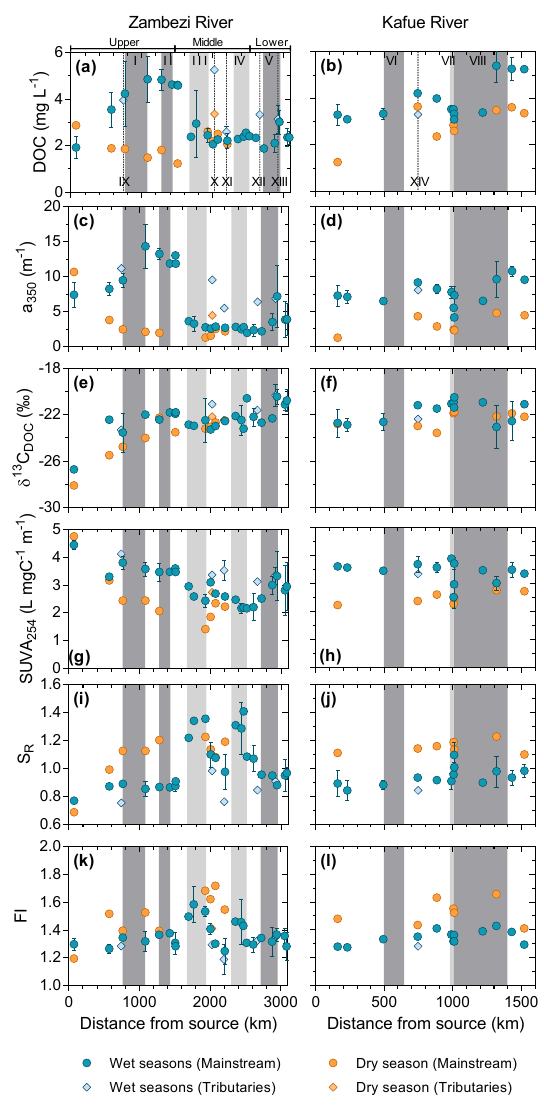
Figure 3. Longitudinal variations in DOM properties along the Zambezi River (left panels) and the Kafue River (right panels) dur- ing the wet and the dry seasons. From top to bottom, the panels represent DOC, a 350 , δ 13 C DOC , SUVA 254 , S R and FI. Dark-gray and light-gray rectangles in the background represent the approx- imate position along the mainstream of wetlands/floodplains areas and reservoirs, respectively. Roman numerals refer to (I) Barotse Floodplain, (II) Chobe Swamps, (III) Kariba Reservoir, (IV) Ca- hora Bassa Reservoir, (V) lower Zambezi wetlands for the Zam- bezi River and (VI) Lukanga Swamps, (VII) Itezhi Tezhi Reservoir, and (VIII) Kafue Flats for the Kafue River. The diamonds represent samples collected from main tributaries upstream of their conflu- ence with mainstreams: (IX) the Kabompo, (X) the Kafue, (XI) the Luangwa, (XII) the Mazoe and (XIII) Shire River for the Zambezi River, and (XIV) the Lunga River for the Kafue River. Symbols and error bars for data collected during the wet seasons represent the average and standard deviation between the two field campaigns performed in 2012 and 2013,